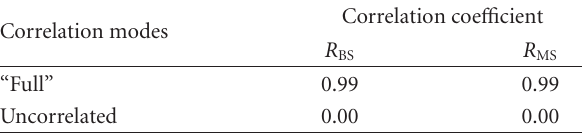
Table 4: Correlation modes and their coe ffi cient.